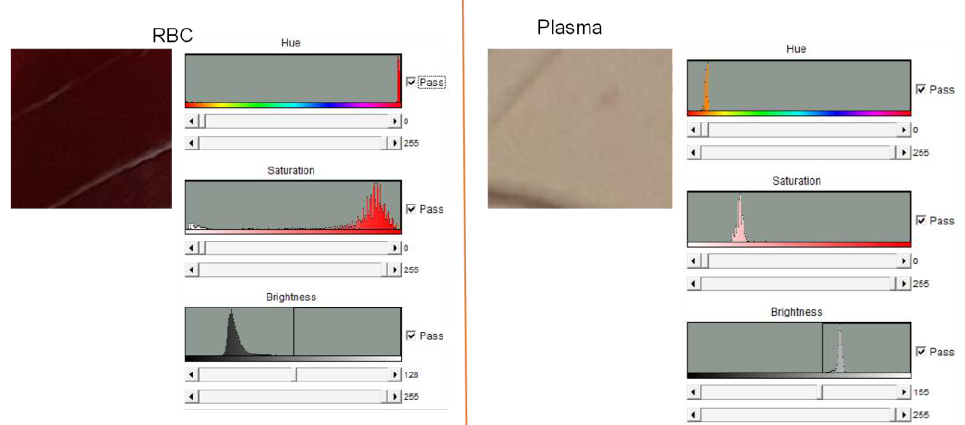
Figure 6. Image analysis performed with ImageJ after the completion of the spin program that sep- arates the red blood cells. Images of the RBC chamber (on the left) demonstrate the strong presence of red hue of the red blood cells that are absent in the image analysis of the reciprocation chamber (on the right).